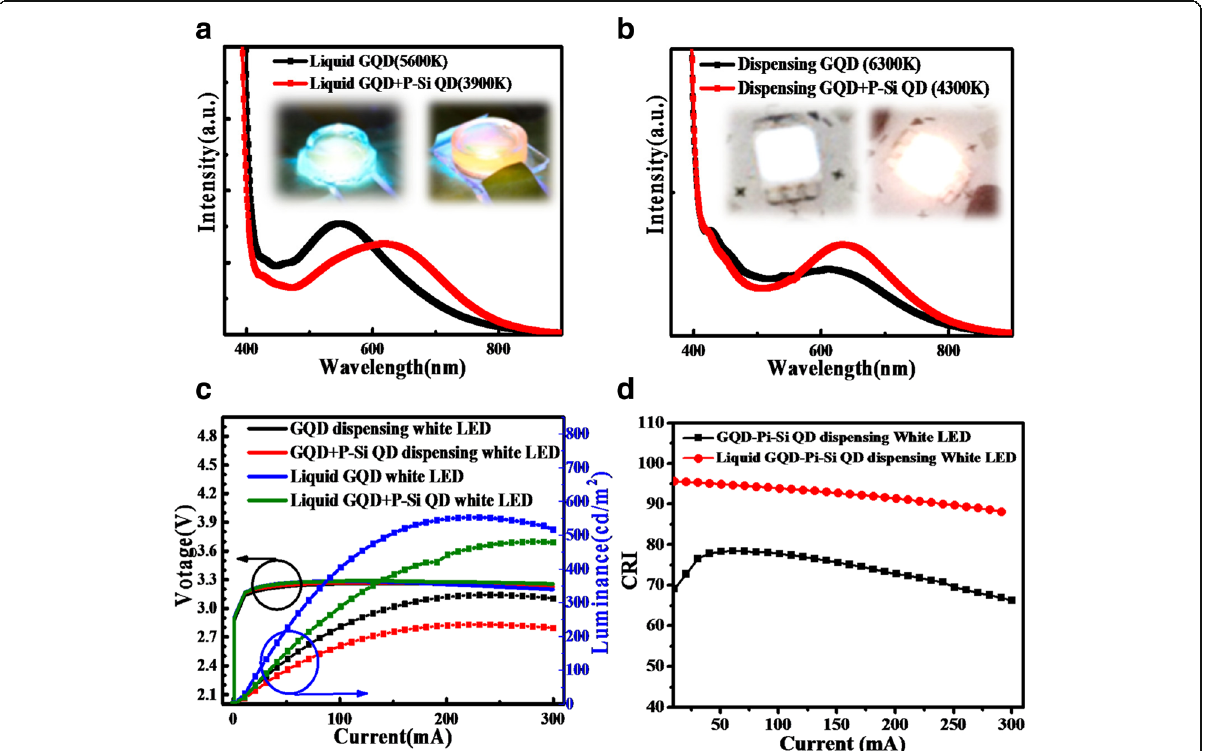
Fig. 4 PL spectra of ( a ) liquid-type graphene QD at a CCT of 5600 K and liquid-type GQD/ P-Si QD white LED at a CCT of 3900 K. b Dispensing graphene QD and graphene/P-Si QD white LEDs. c The LIV curve spectrum of the nontoxic w-LEDs driven at 1 – 300 mA. d CRI spectra for GQD + P-Si dispensing and liquid-type LEDs driven at 1 – 300